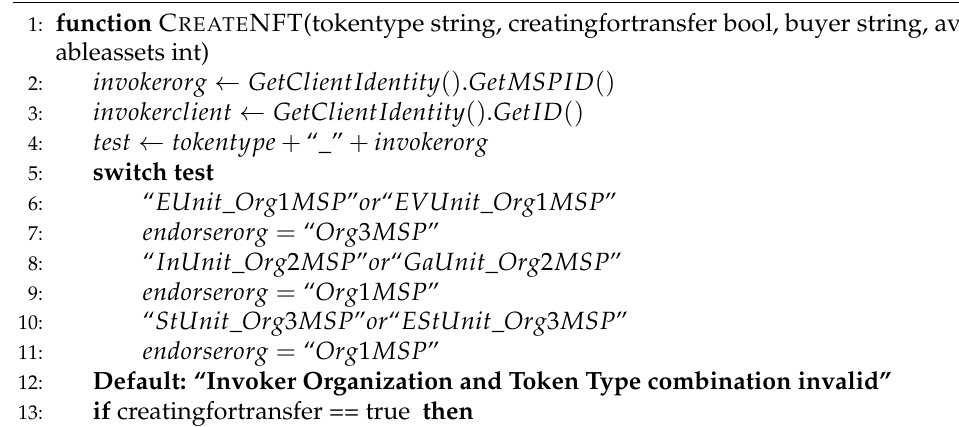
Algorithm 3 Create a